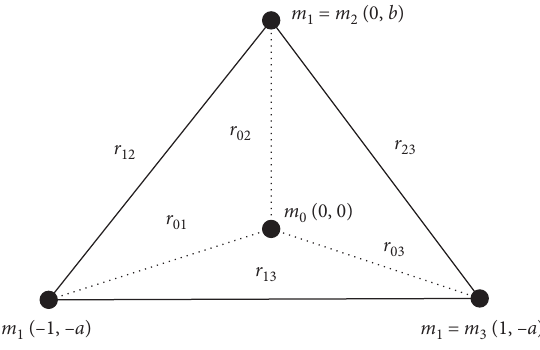
Figure 1: Concave kite four-body configurations with three equal � m � m masses m 1 2 3